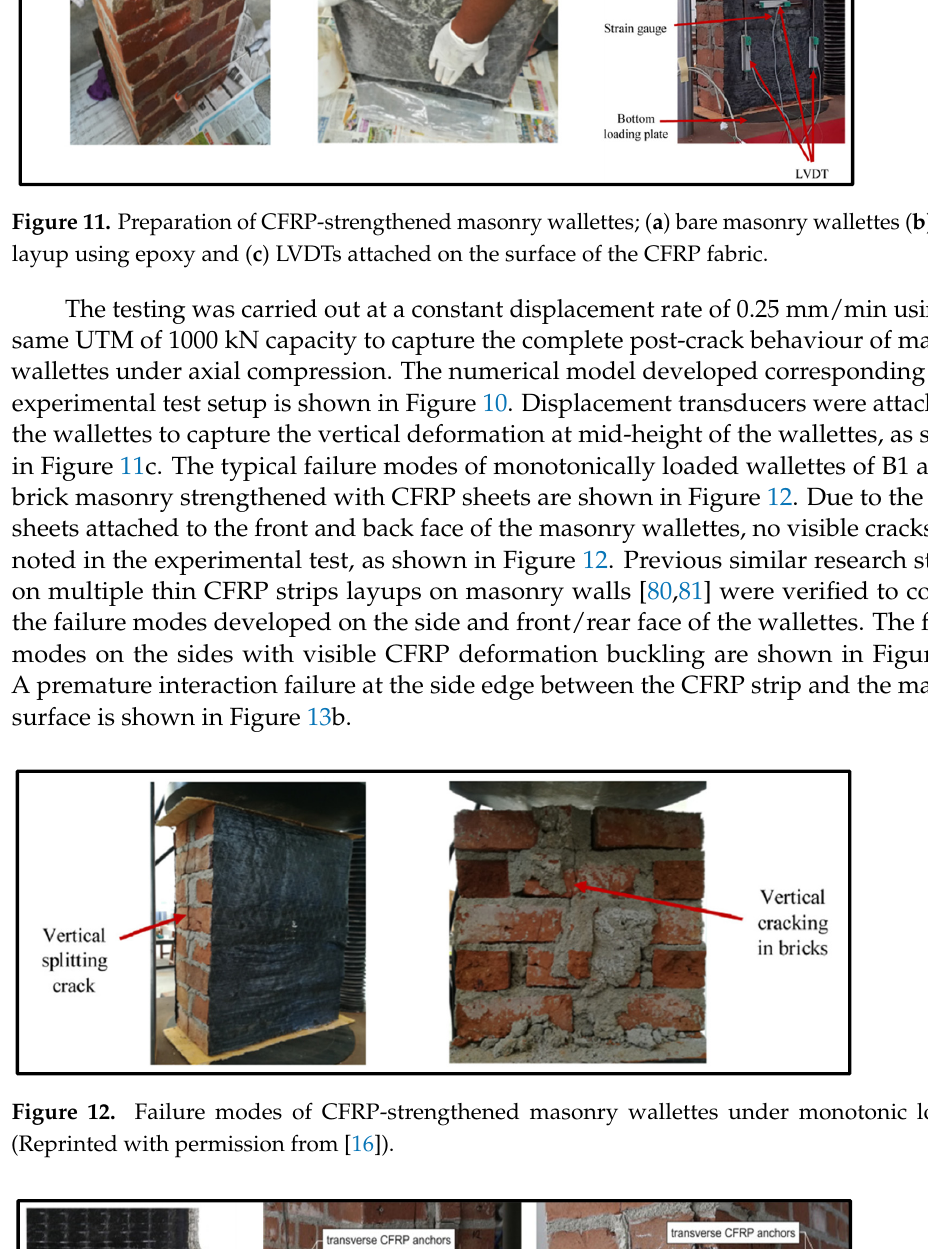
Figure 12. Failure modes of CFRP-strengthened masonry wallettes under monotonic loading (Reprinted with permission from [16]).